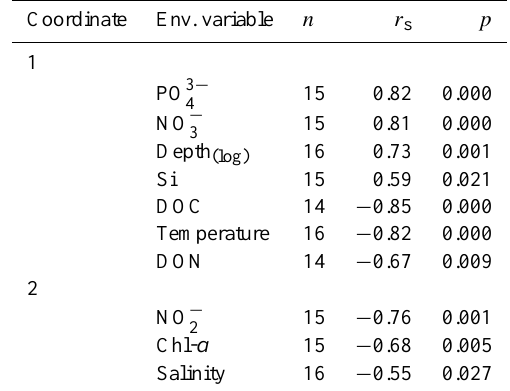
Table 3. Spearman correlations between environmental variables and principal coordinate analysis (PCoA) ordination. Table shows number of available data points ( n ), Spearman correlations ( r s ), and significance value ( p ). Only significant relationships are